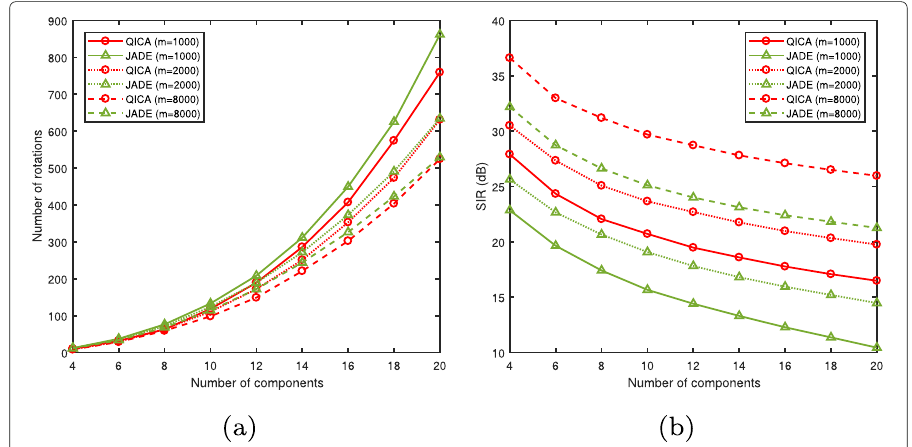
Fig. 6 Comparison of the QICA and JADE algorithms for Laplacian distribution and various numbers of components. a The number of rotations needed to achieve convergence. b SIR index measured after reaching the